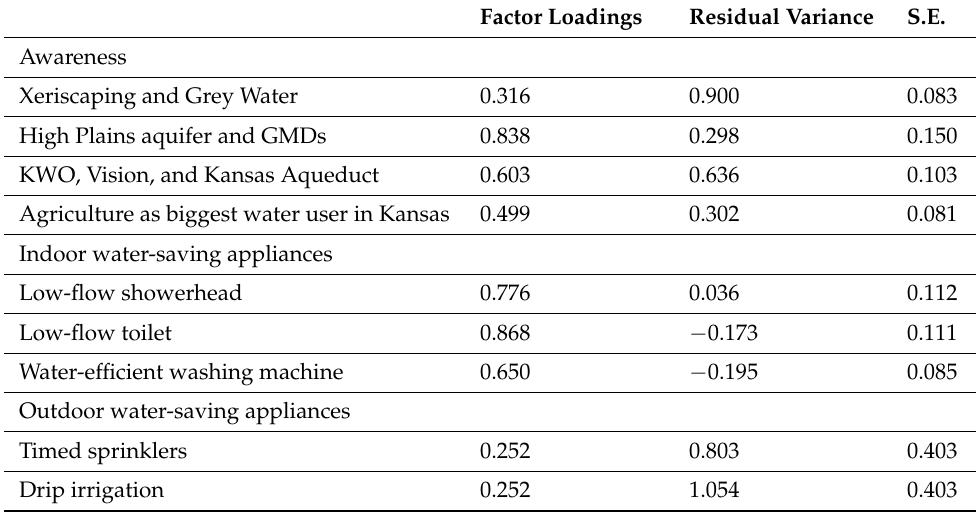
Table A9. Standardized model results of owning water-saving appliances for appliances for indoor and outdoor usage regressed on awareness levels for irrigation well owners (n =